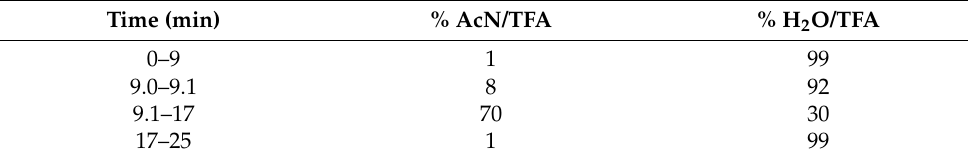
Table 1. Gradient conditions used for chromatographic separation of peptides.